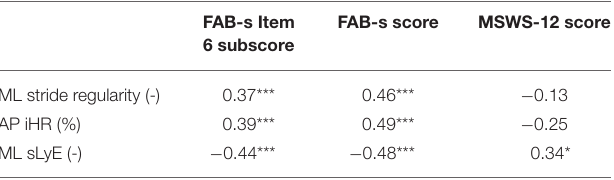
TABLE 5 | Spearman’s correlation coefficient ( r s ) between instrumented metrics and clinical